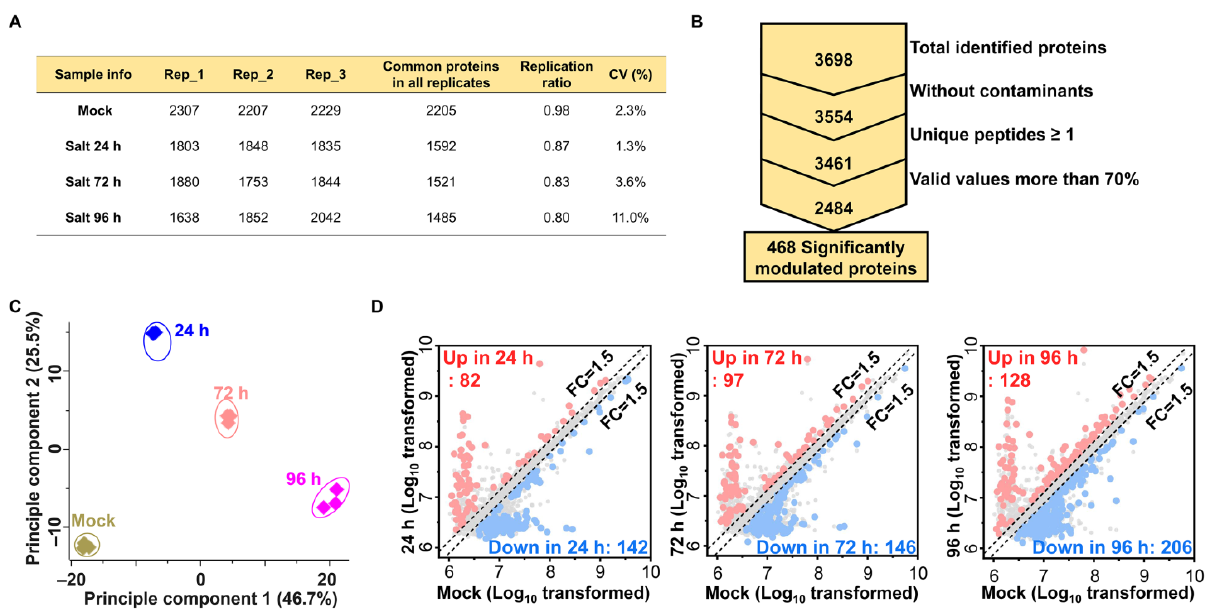
Figure 2. Proteomic analysis of ginseng leaves in response to salt stress treatment for 24 h, 72 h, and 96 h. ( A ) Overview of the proteins identified in three biological replicates of ginseng samples treated with different durations of salt stress. ( B ) The distribution of the total identified and significantly modulated proteins. ( C ) Principal component analysis showing a clear separation of significantly modulated proteins. ( D ) Volcano plots highlighting more than 1.5-fold relative fold changes among the four samples.